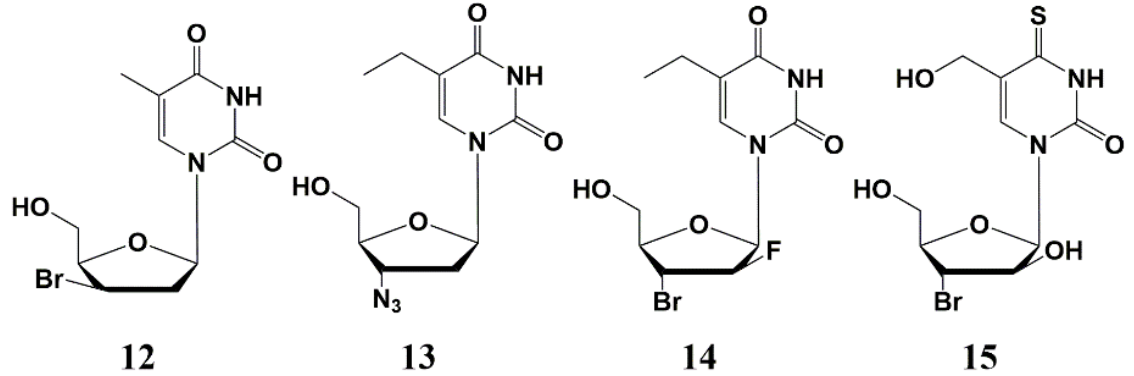
Figure 3. Pyrimidine nucleosides modified at the carbohydrate moiety 12 – 15 —inhibitors of mycobacteria growth.